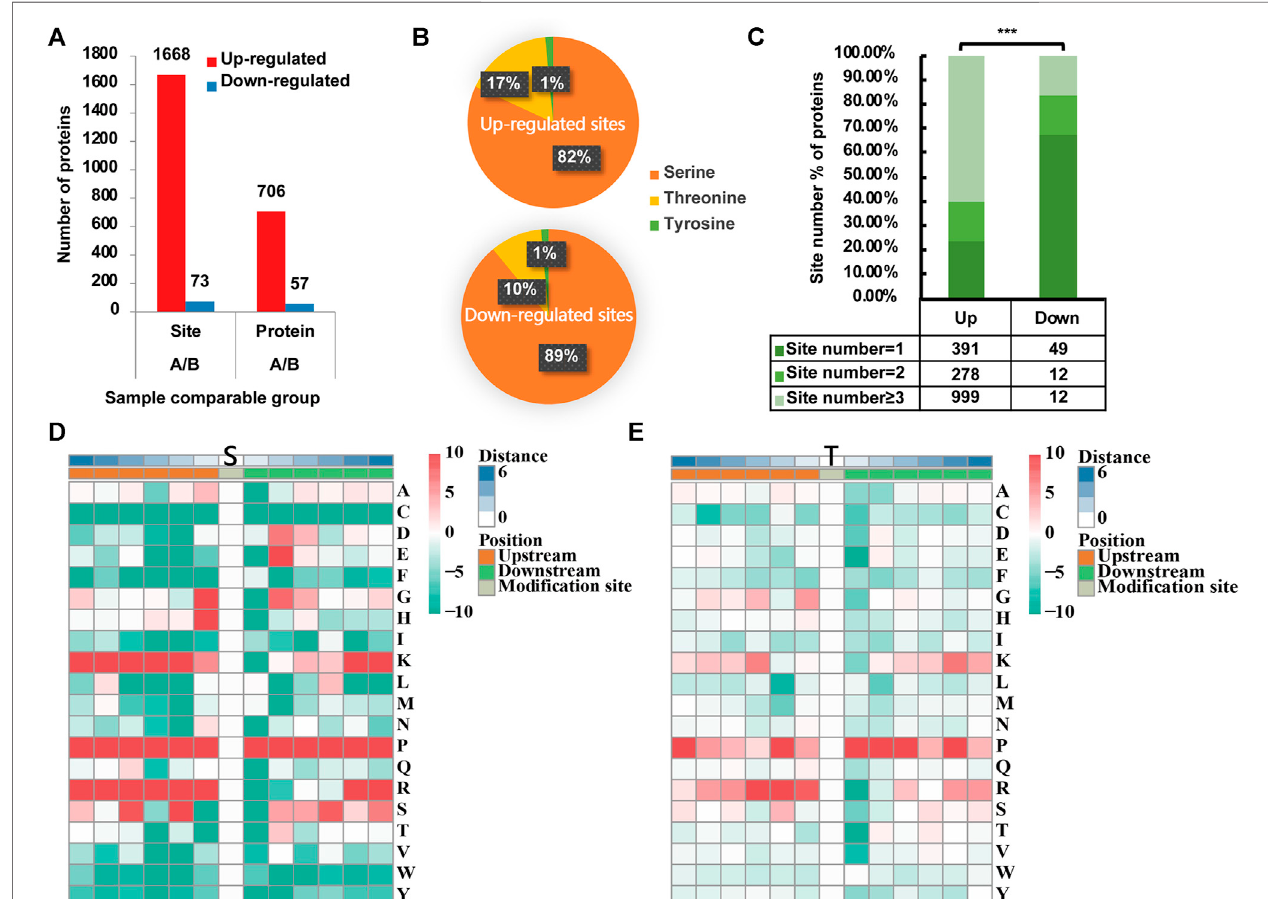
FIGURE1| Phosphoproteomicpro fi leinrotatorcufftendinopathysite. (A) 1,668p-sitesin706proteinswereidenti fi edasupregulated,while73sitesin57proteins weredownregulated. (B) Amongupregulatedsites(upperchart),1,366locatedinserine(S),accountingfor82%oftotalupregulatedsites;277(17%)inthreonine(T)and 25 (1%) in tyrosine (Y). Comparatively, downregulated sites (lower chart) occurred in 65 S (89%), 7 T (10%), and 1 Y (1%). (C) For proteins with upregulated p-sites, 23.44%have 1siteupregulated,16.67%have2sites, and59.89%have3ormoresitesupregulated.Onthecontrary,forproteinswithdownregulatedp-sites, the large majority of proteins (67.12%) have only 1 site downregulated. Statistical signi fi cance was assessed using Pearson ’ s χ 2 test; *** p < 0.001. (D) Analysis of the serine p-site motif in the adjacent 6 positions either upstream or downstream ( − 6~+6). (E) Tyrosine p-site motif in the adjacent 6 positions either upstream or downstream ( − 6~+6).